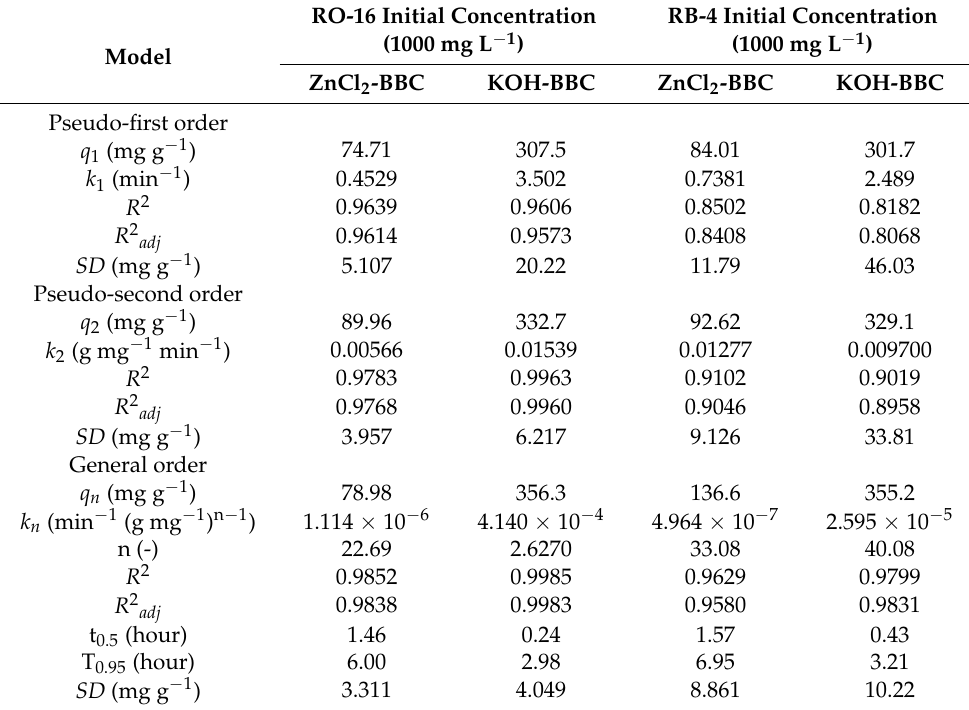
Table 5. Kinetic parameters of RO-16 and RB-4 adsorption onto the BBC